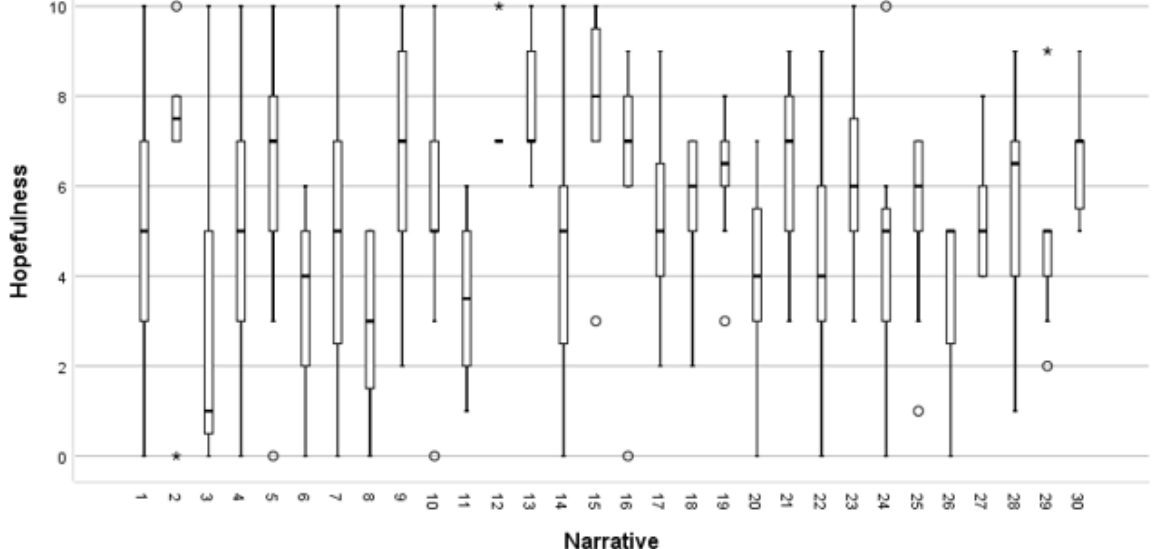
Figure 4. Ratings by participants (N=40) of hopefulness for each